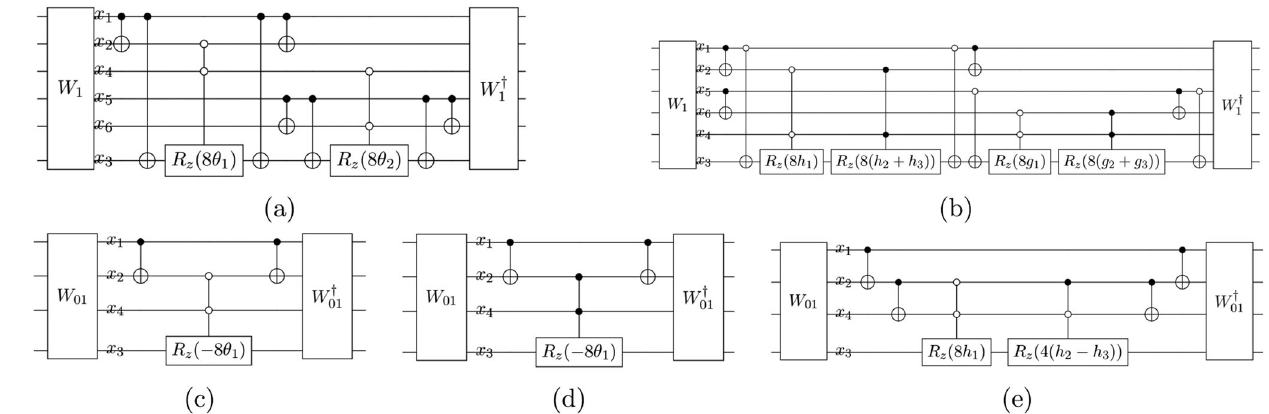
Fig. 3 Quantum circuit for e (cid:1) iH 21 t and e (cid:1) iH 201 t . ( a , b ): Circuit simulating e (cid:2) iH 21 t ( a ) when a 2 t = a 3 t = a 4 t = a 5 t = θ 1 and b 2 t = b 3 t = b 4 t = b 5 t = θ 2 ; ( b ) when the coef fi cients are as in Equation 18. ( c – e ) Circuit simulating e (cid:2) iH 201 t ( c ) when a 1 t = a 6 t = − θ 1 , b 1 t = b 6 t = − θ 2 , a 0 t = a 7 t = θ 1 and b 0 t = b 7 t = θ 2 ; ( d ) when a 0 t = … = a 7 t = θ 1 and b 0 t = … = b 7 t = θ 2 ; ( e ) when the coef fi cients are as in Equation